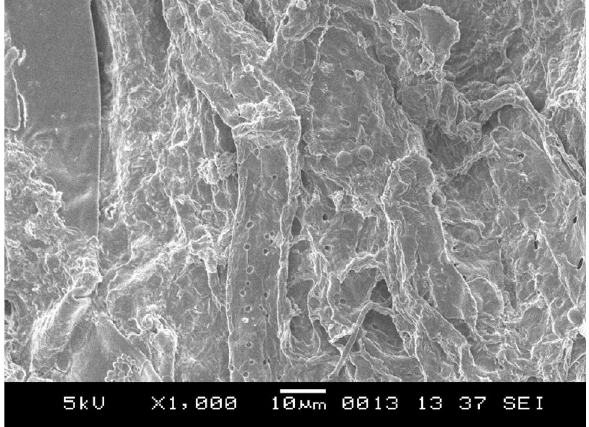
Fig. 6 SEM analysis of raw TLP before